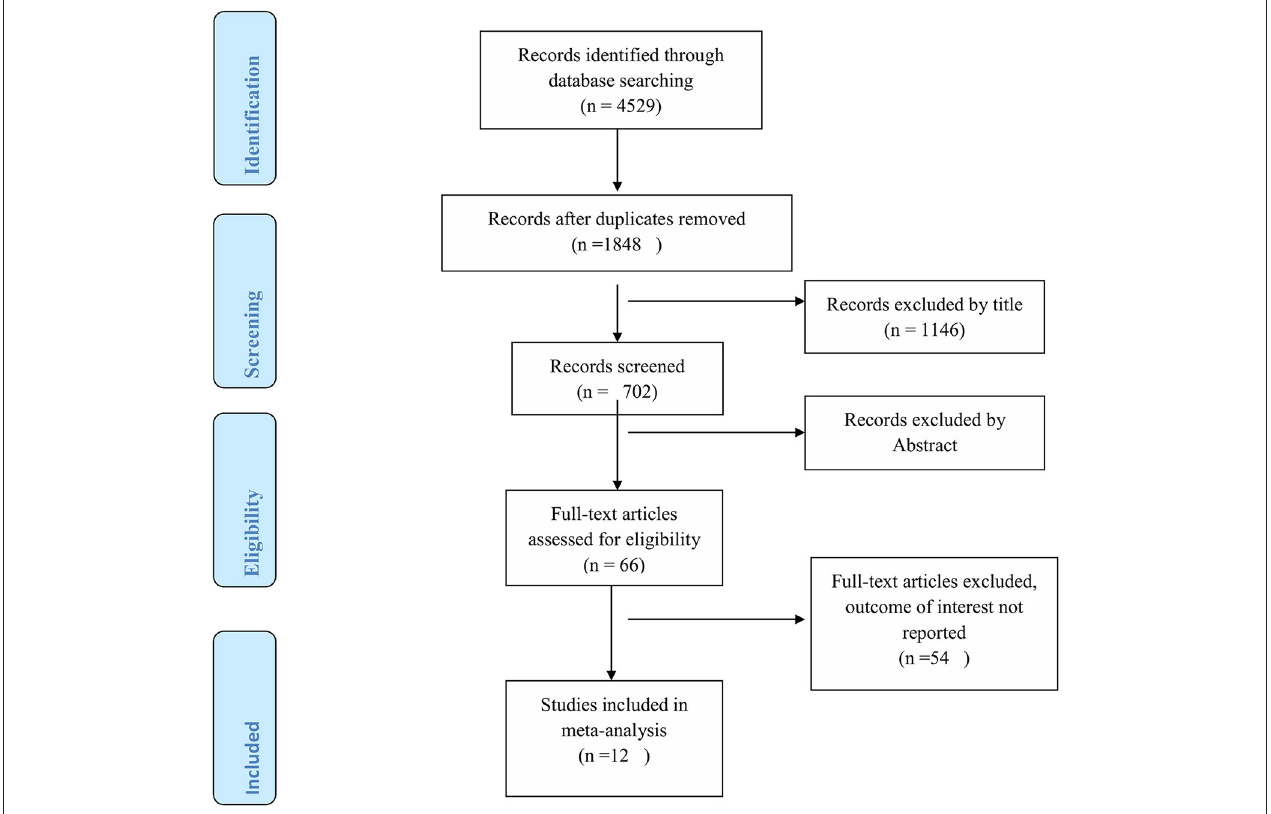
FIGURE 1 | PRISMA flow diagram of study